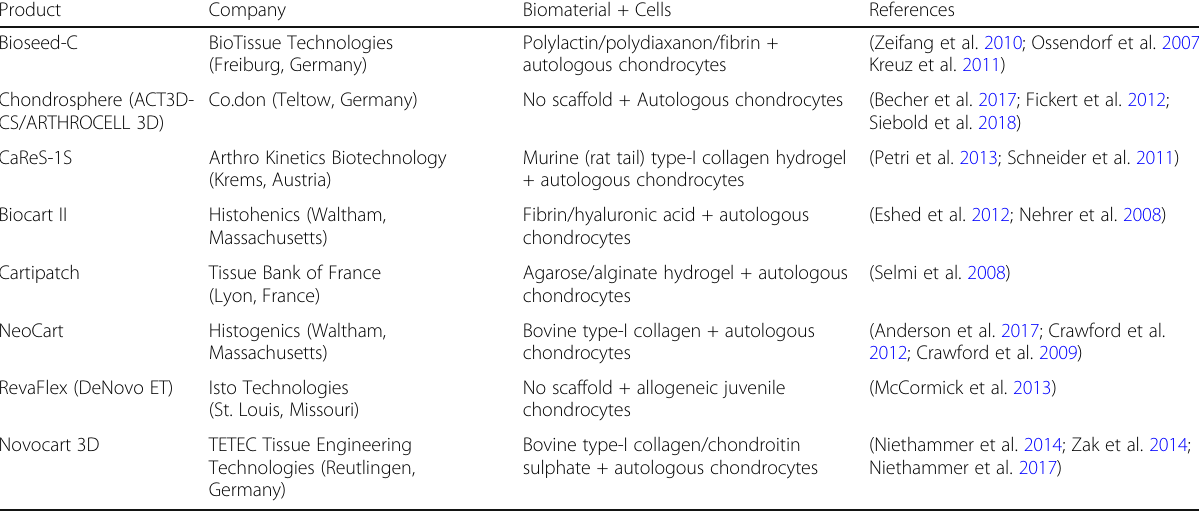
Table 2 Examples of commercial products for cartilage repair Product